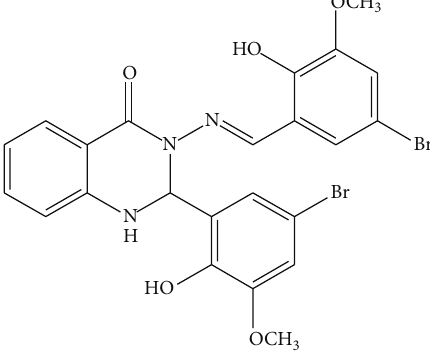
Figure 3: Compound (1).